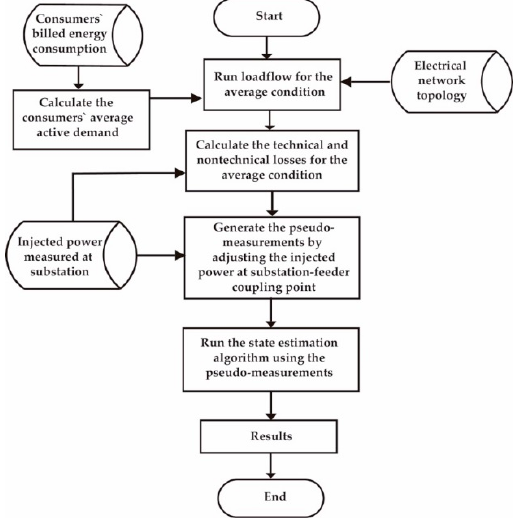
Figure 2. Pseudo-measurement generation flowchart.